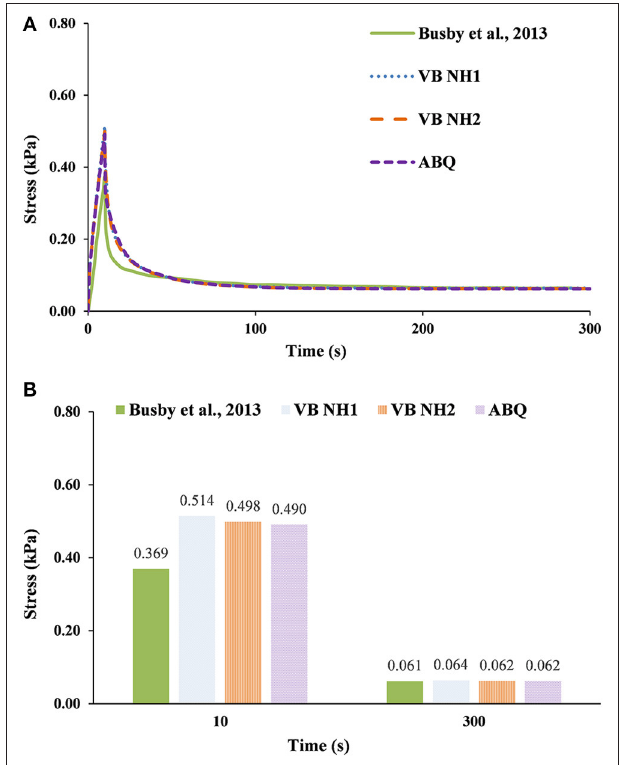
FIGURE 6 | 0.40% collagen hydrogel during stress relaxation tests. The experimental data of Busby et al. (2013) is here compared with numerical calculations using V-Biomech, and Abaqus: (A) Stress relaxation over time; (B) Peak and end effective stress